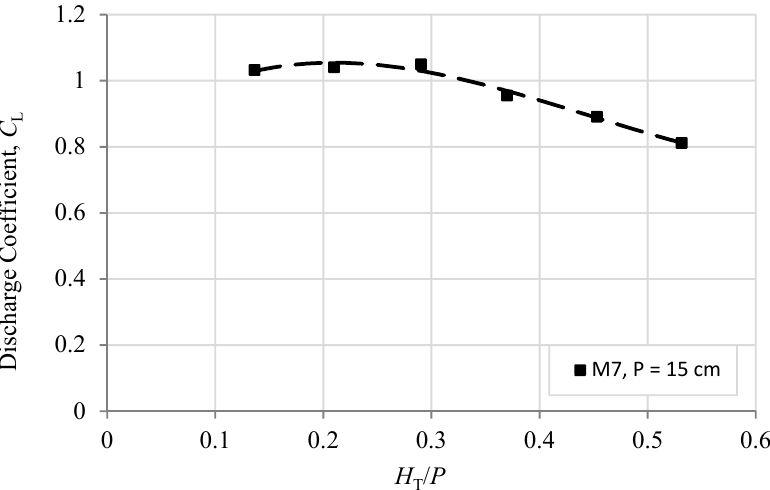
Figure 11. Variations in the discharge coefficient, C L , as a function of the H T /P ratio for the M7 model.